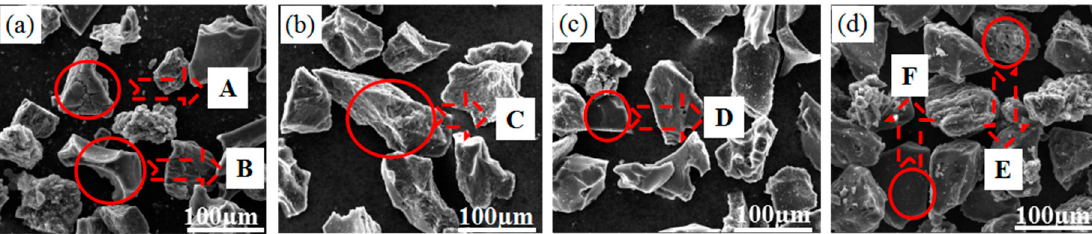
Figure 3. Morphology of carbonaceous materials in the recycling dust, coal char (CC) and coke: ( a ) RD; ( b ) C-1; ( c ) C-2; and ( d ) CC. A : ablative structure; B : irregular and sharp edge; C : irregular edge and rough surface; D : sharp edge and smooth surface; E : small pores; and F : irregular edge and smooth surface.